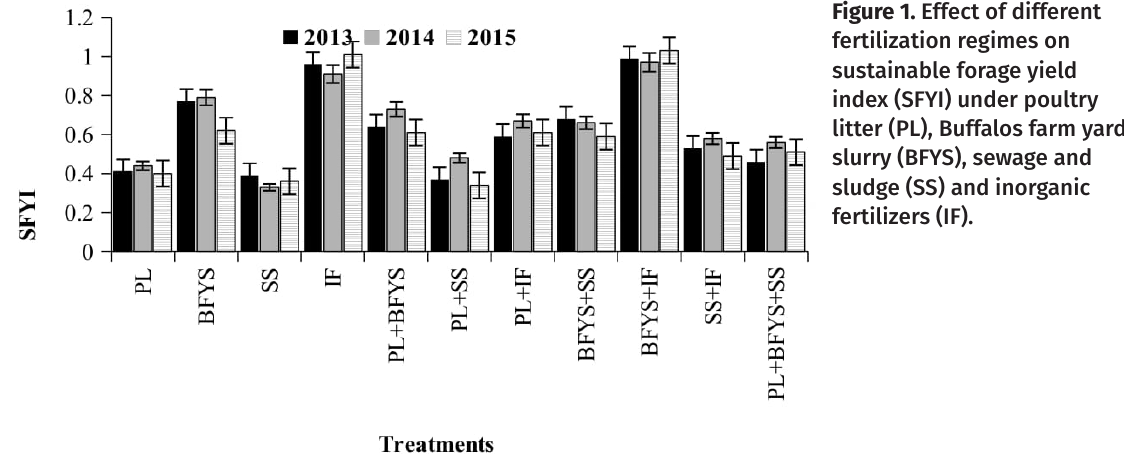
Figure 1. Effect of different fertilization regimes on sustainable forage yield index (SFYI) under poultry litter (PL), Buffalos farm yard slurry (BFYS), sewage and sludge (SS) and inorganic fertilizers (IF).